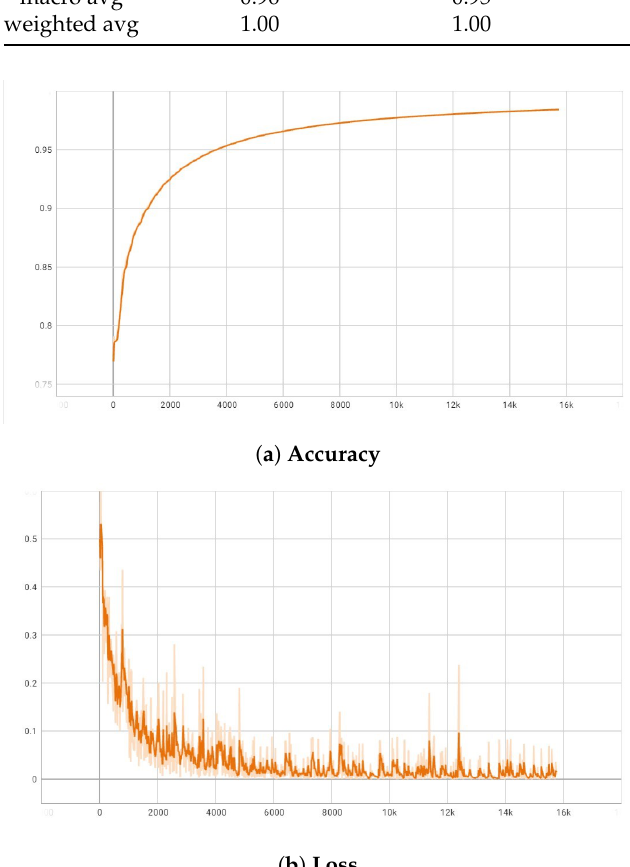
Figure 7. VulEye training